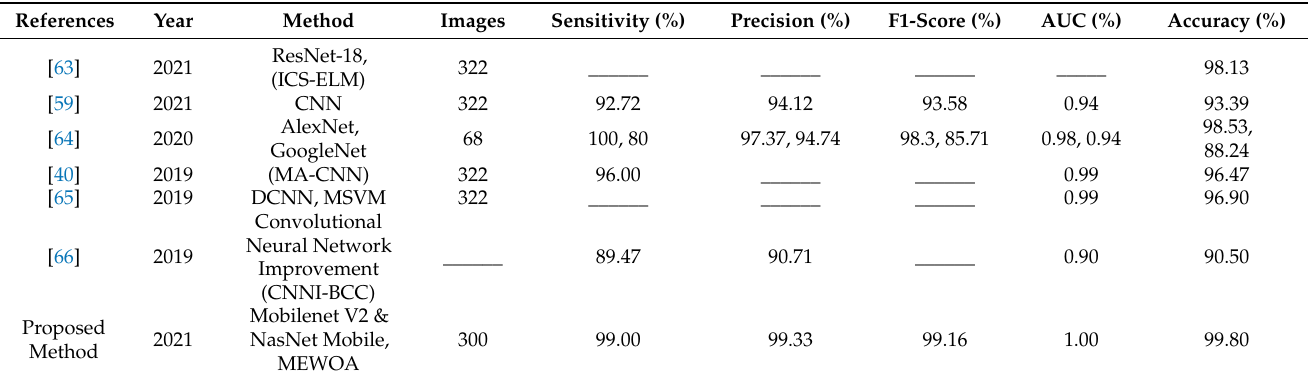
Table 21 contrasts comparative analysis on MIAS dataset classification images. The number of images, methods, sensitivity, precision, F1-score, AUC, and accuracy compared with the other studies. The proposed method shows good results compared to other studies. Table 21. Comparisons with the state of the art for the MIAS Dataset.